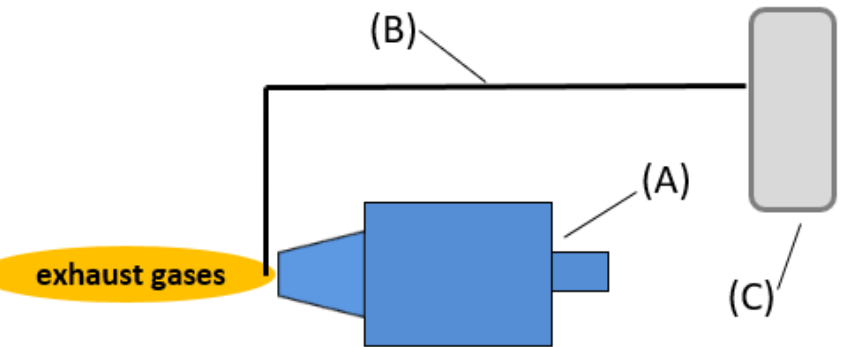
Figure 1. Test rig ( A )—miniature test engine, ( B )—exhaust pipe, ( C )—exhaust gas collection and storage system. Table 1. Technical parameters of GTM-140 engine. Parameters Descriptions